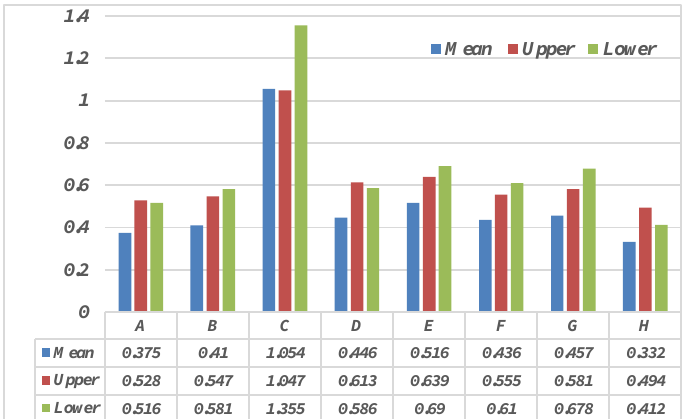
Figure 7. Histogram of the distribution of the maximum effective plastic strain values of the perfo- rated titanium sheet at the end of forming.